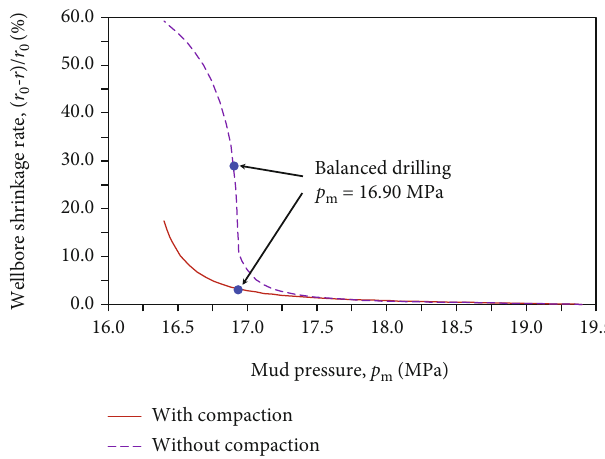
− r Þ / r 0 0 varying with mud pressure